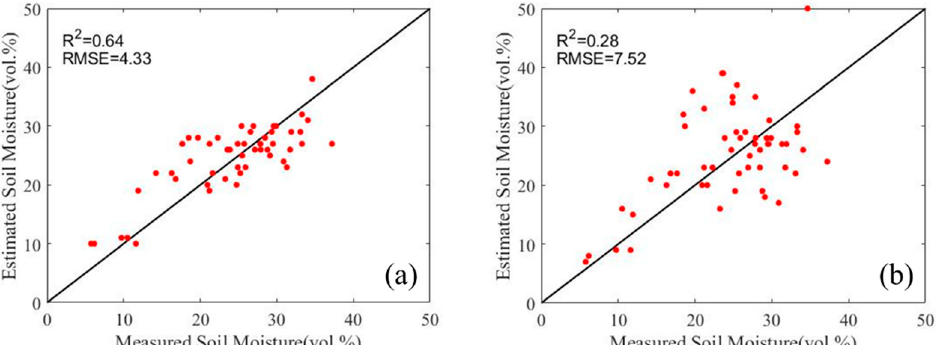
Figure 10. ( a ) Scatterplots between the measured and predicted SMC values on the validation set based on LAI (WCM); ( b ) scatterplots between the measured and predicted SMC values on the validation set based on RVI, the same date as LAI (WCM).